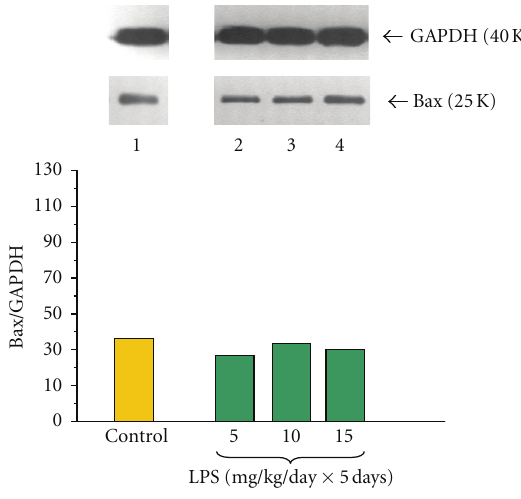
Figure 5: Western blot analysis of Bax protein level in the adult rat pancreatic acinar cells under basal conditions (lane 1), treated in the infant animals by lipopolysaccharide ( Escherichia coli ) at the doses of 5mg/kg/day × 5 days (lane 2), 10 mg/kg/day × 5 days (lane 3), and 15 mg/kg/day × 5 days (lane 4) after 5 hours of incubation. The blots were stripped and probed with GAPDH to document equal protein loading. All presented results were obtained in 4 consecutive experiments and are representative of the observed